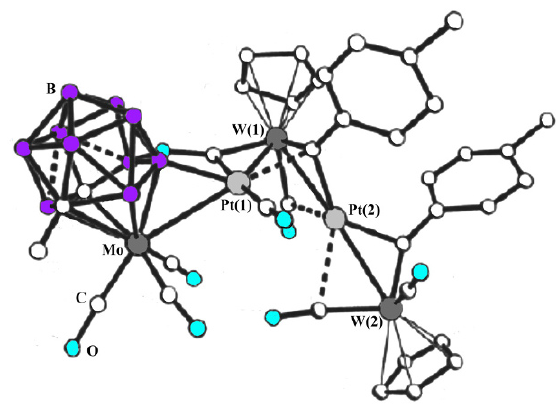
Figure 6. Structure of [(cp)(CO)